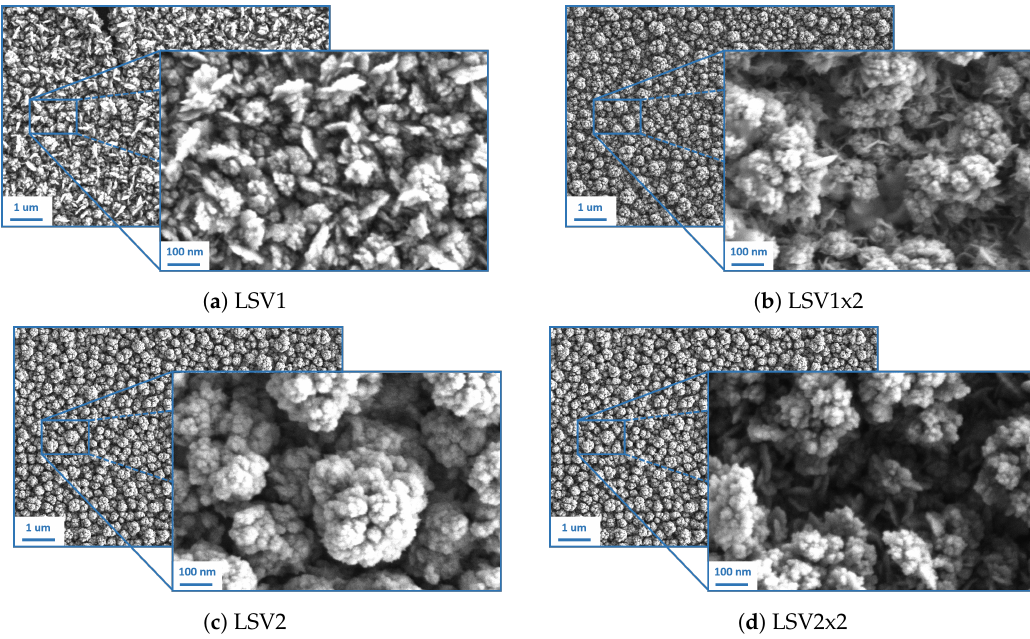
Figure 1. Scanning electron microscopy (SEM) images of platinum nanostructures deposited by linear sweep voltammetry (LSV) with different voltage ranges: between 0 and − 0.6 V for the procedures called LSV1 ( a ), between 0 and − 0.8 V for LSV2 ( c ). The comparisons with the structures obtained with two subsequent depositions is given in ( b ) and ( d